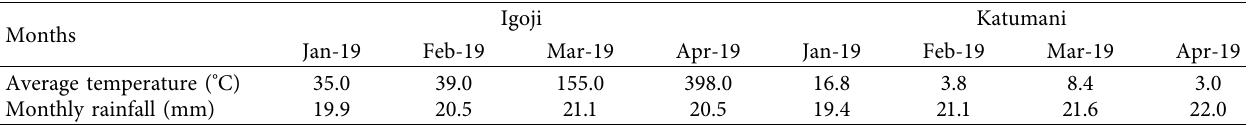
Table 1: Monthly rainfall and temperature from flowering to physiological maturity of sorghum during 2018/2019 short rains at the KALRO research stations in Igoji and Katumani. Months